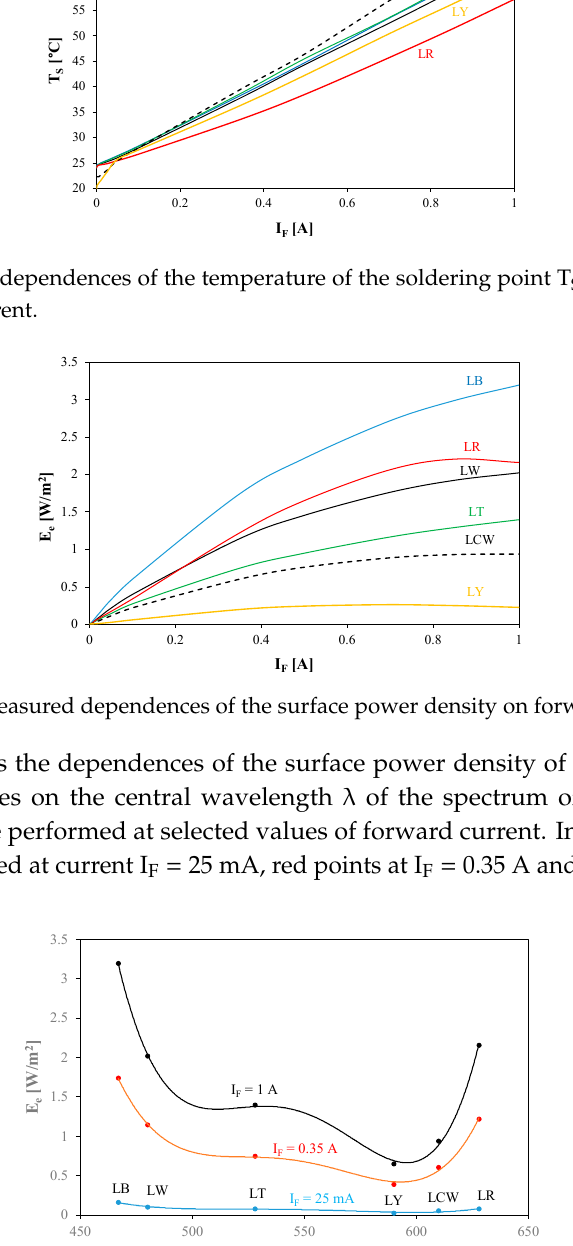
Figure 12. Measured and calculated dependences of the surface power density on the surface illuminated by the tested LEDs on the central wavelength λ of the spectrum of the emitted radiation for selected values of forward current of these diodes.